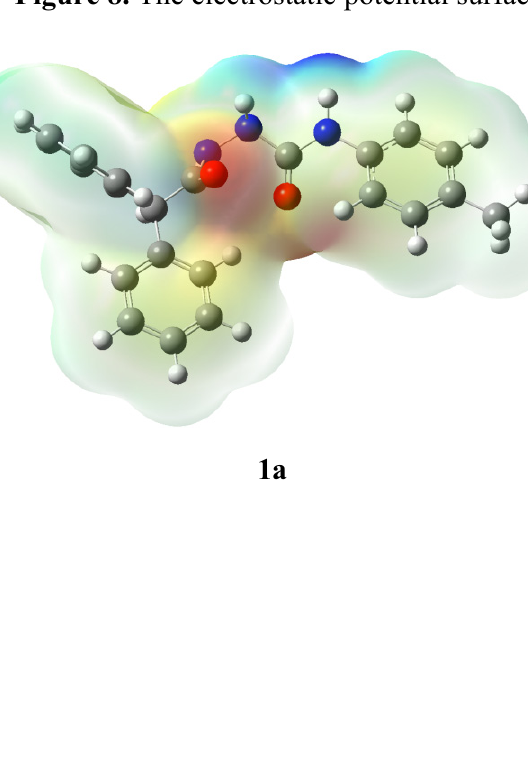
Figure 8. The electrostatic potential surfaces of semicarbazides a and thiosemicarbazides b